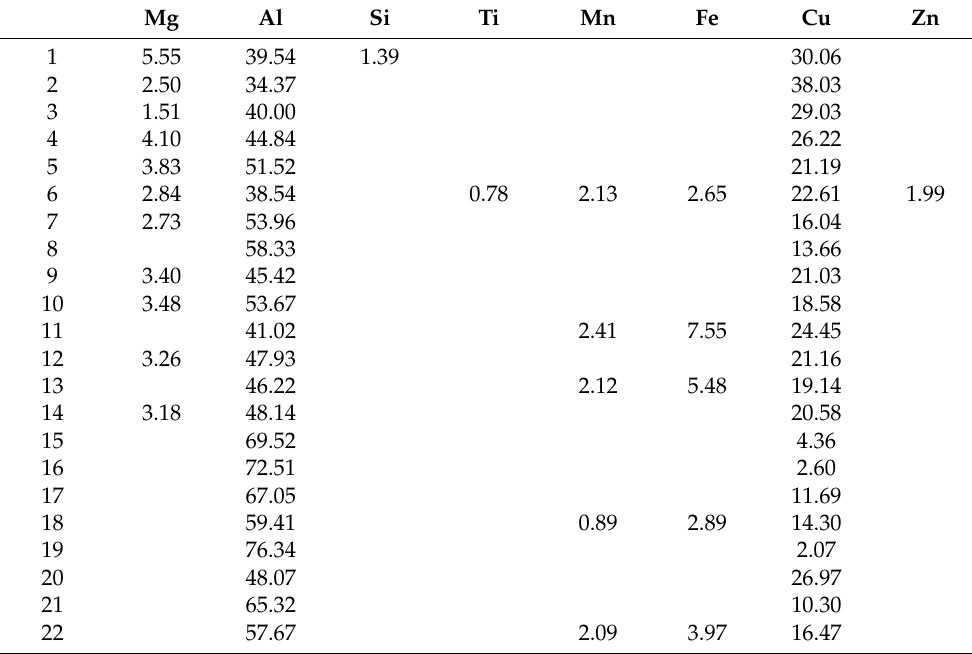
Table 2. The EDS results of the thermal deformation microstructure (wt.%).